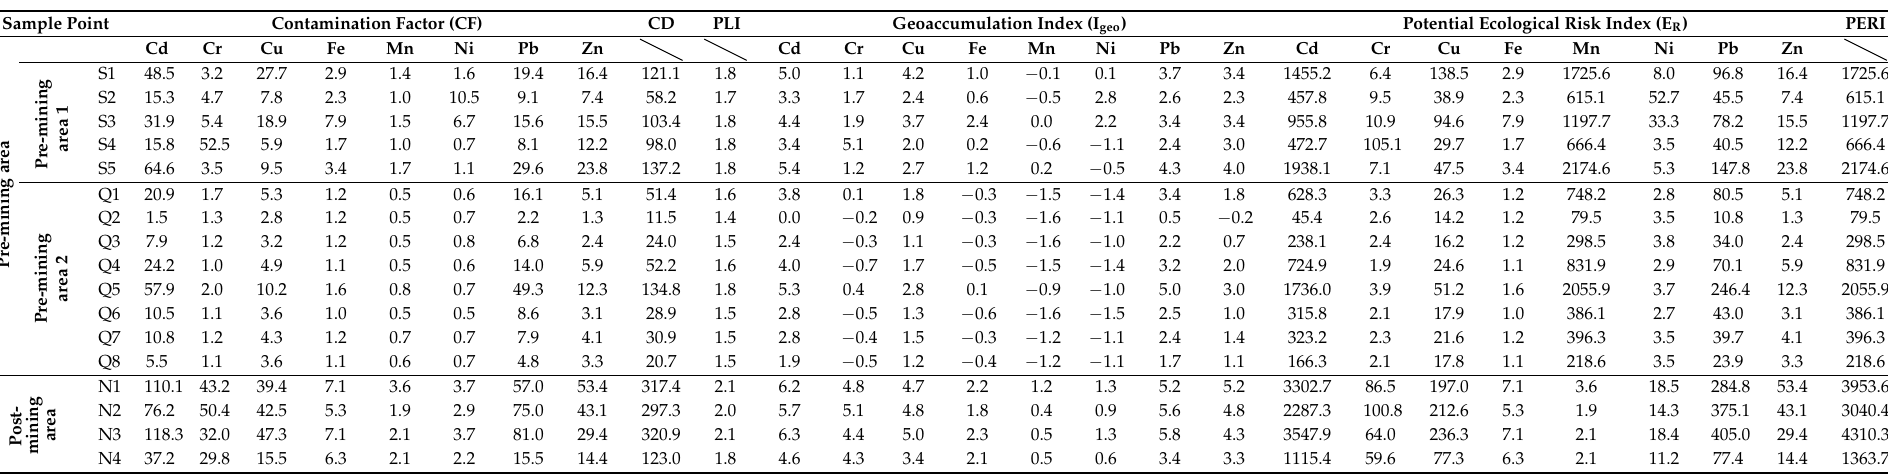
Table 5. Indices of pollution for the studied